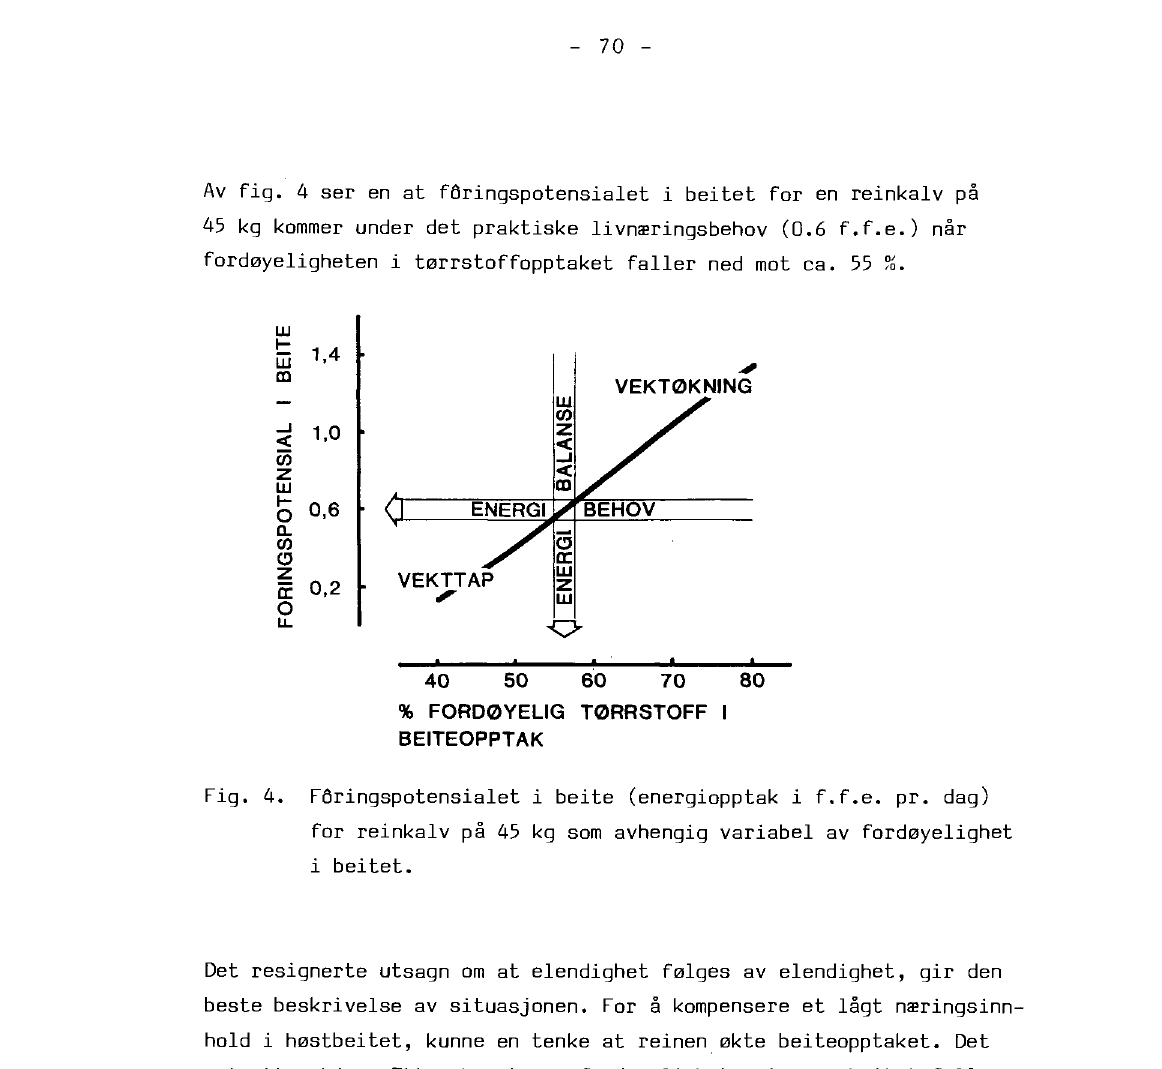
Fig. 4. FQringspotensialet i beite (energiopptak i f.f.e. pr. dag) for reinkalv på 45 kg som avhengig variabel av fordøyelighet i